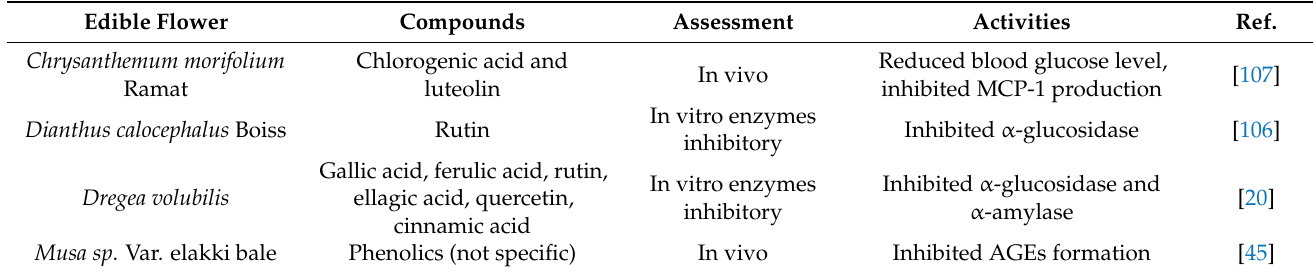
Table 7. Antidiabetic activities in edible